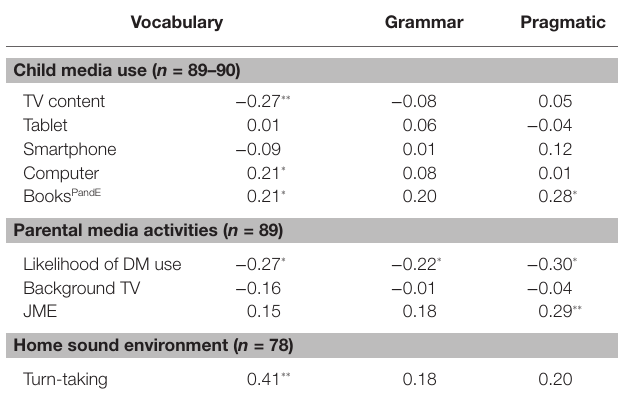
TABLE 6 | Correlations between three measures of language development, and child media use, parental DM use, parental mediation and home sound environment